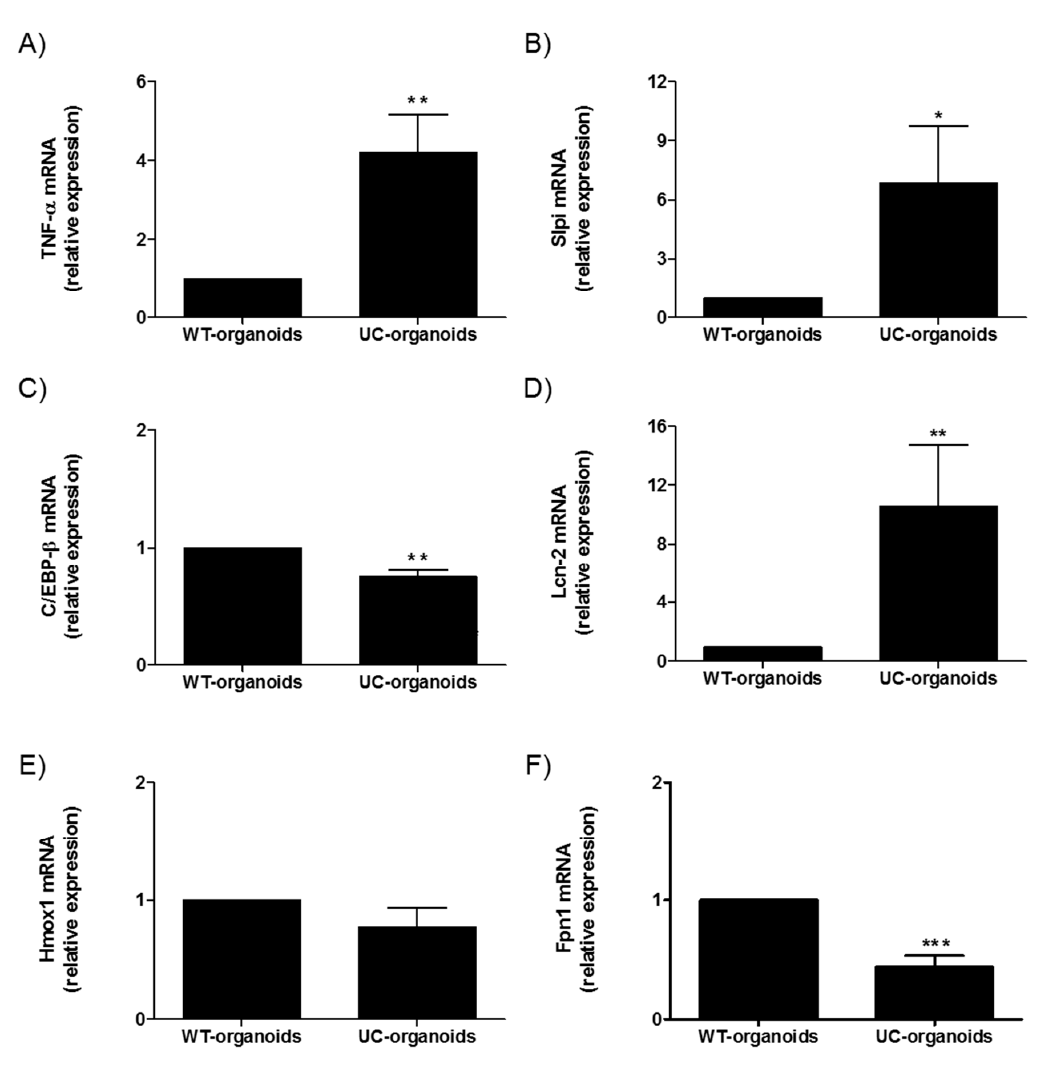
Figure 5. Comparison between small-intestinal WT- and UC-organoids. Expression of TNF- α ( A ), Slpi ( B ), C / EBP- β ( C ), LCN-2 ( D ), Hmox ( E ), and Fpn1 ( F ) was detected by real-time PCR. Relative expression of selected genes was calculated relative to WT-organoids. Histograms represent mean expression ± SEM of four independent experiments. Unpaired two-tailed Student’s t-test was used for statistical analysis. *** p < 0.001, ** p < 0.01, * p < 0.05.